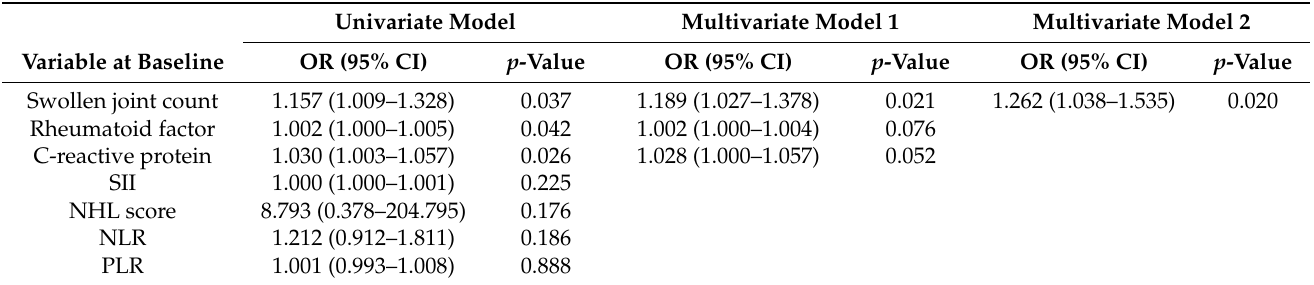
Table 5. Analysis for non-response to JAK inhibitors for 24 weeks in patients with RA. Univariate Model Multivariate Model 1 Multivariate Model